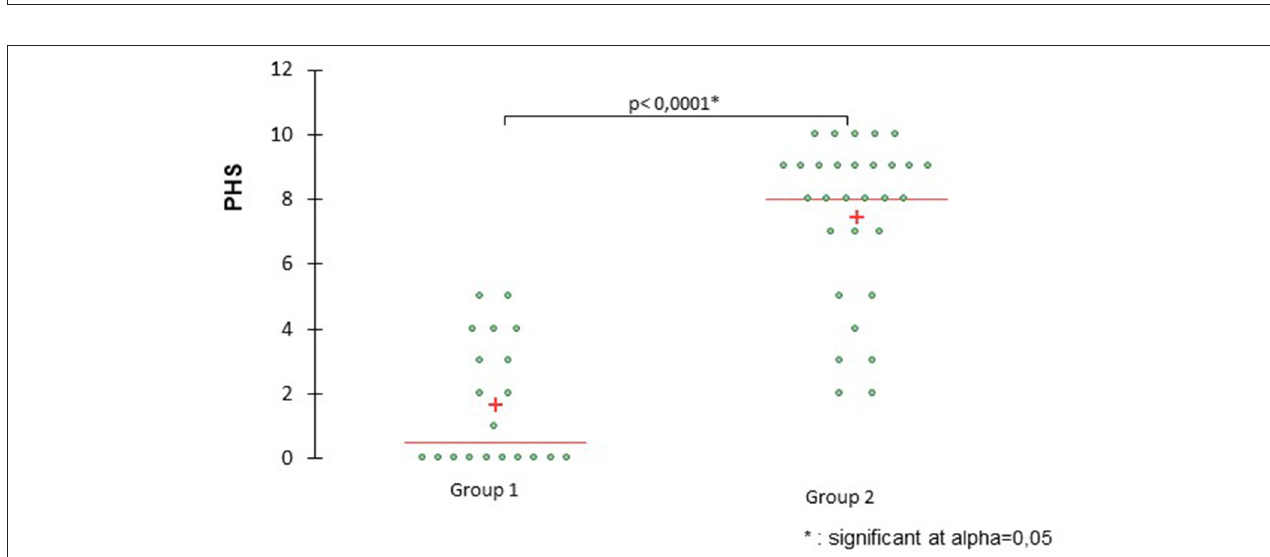
FIGURE 1 | Scatter plots comparing global scores between C1 (control group), C2 (mild PCPH), C3 (moderate PCPH), and C4 (severe PCPH) to detect PCPH. The pulmonary hypertension (PHS) score is significantly higher for C4 than for C1, C2, and C3. The PHS for C3 is significantly higher than G1. The cross indicates the mean value and the horizontal line represents the median value.